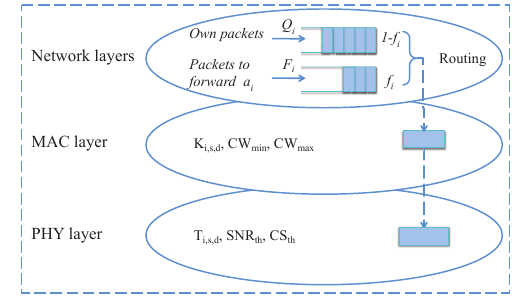
Figure 1. Interaction between NET, MAC and PHY